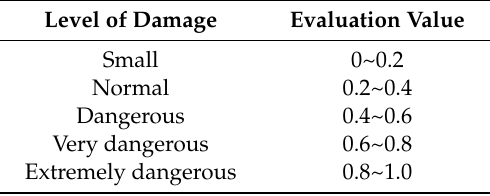
Table A1. Level of Damage.